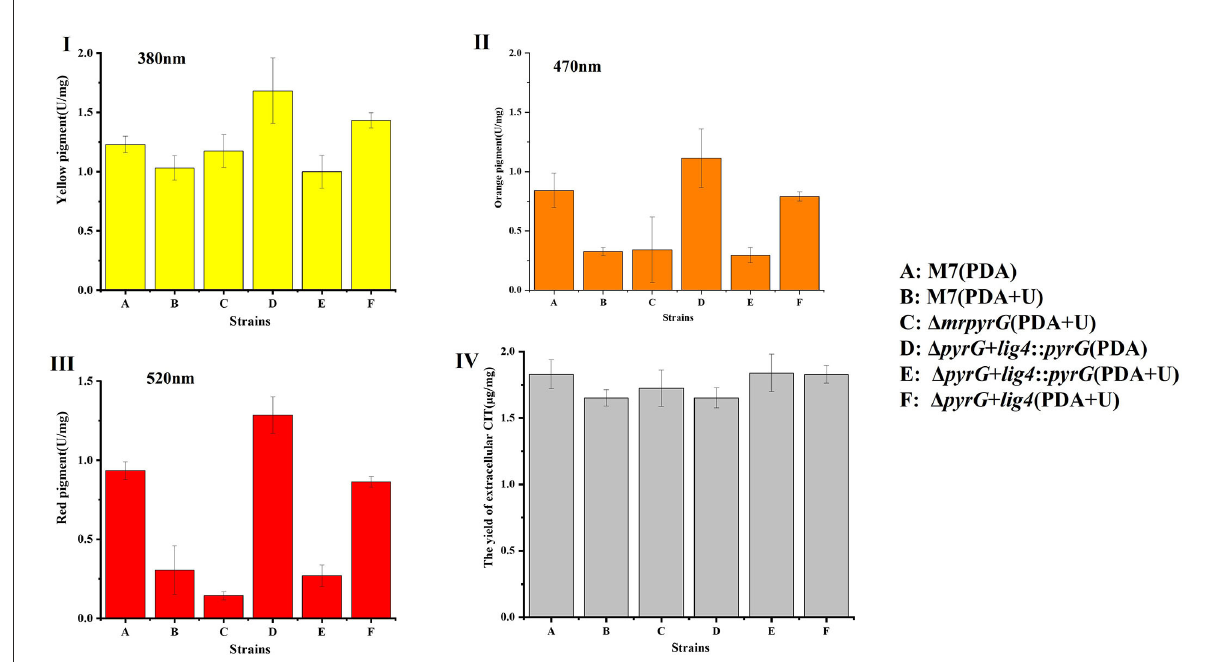
FIGURE4 Production of intracellular MPs and extracellular CIT by M. ruber M7 and derivative markerless deletion strains on the PDA supplied with/without uridine. (I) The yield of yellow pigments; (II) The yield of orange pigments; (III) The yield of red pigments; and (IV) The yield of CIT.